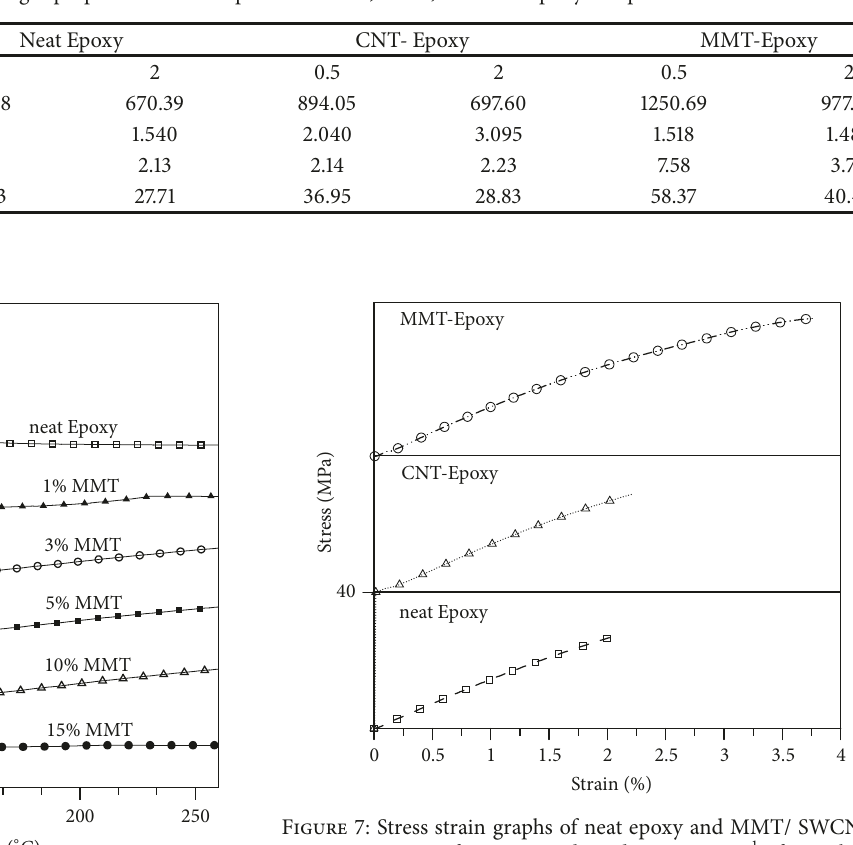
Table 3: Tensile strength properties of block specimens: neat, MMT, and CNT epoxy composites.